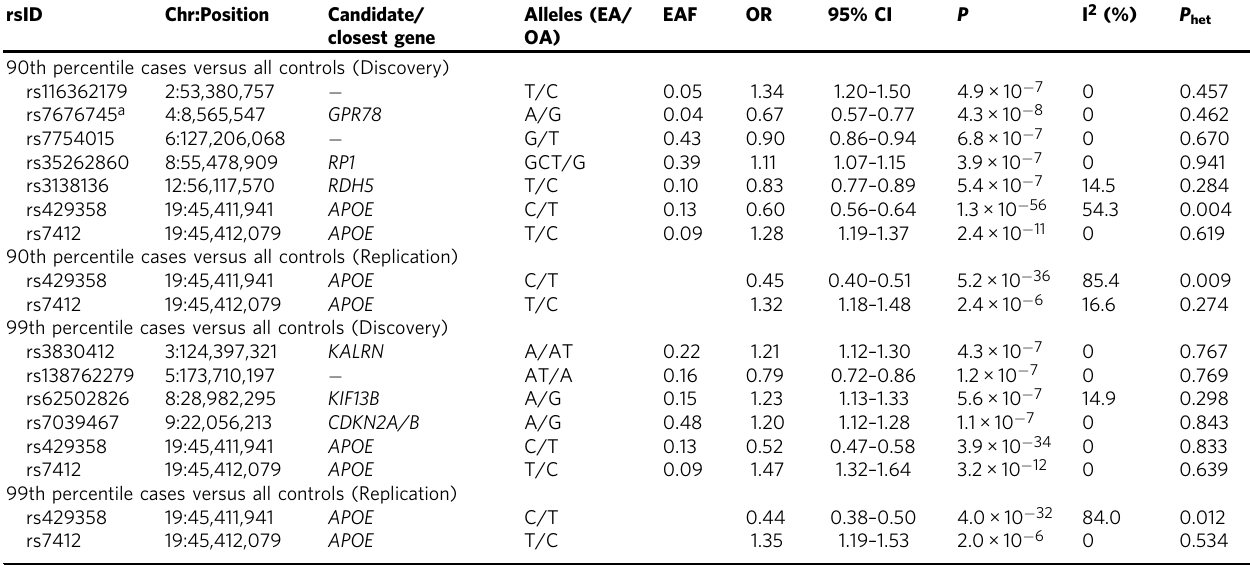
Table 2 Results of the European genome-wide association meta-analyses and replication in the de novo genotyped cohorts rsID 90th percentile cases versus all controls (Discovery)